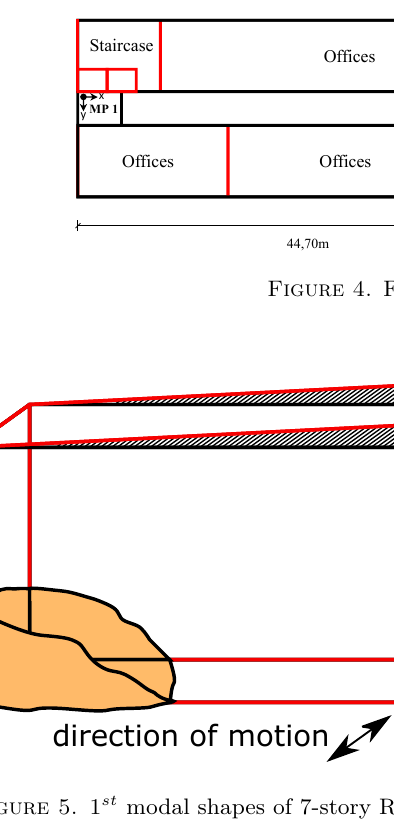
Figure 5. 1 st modal shapes of 7-story RC-building identified by using FDD.